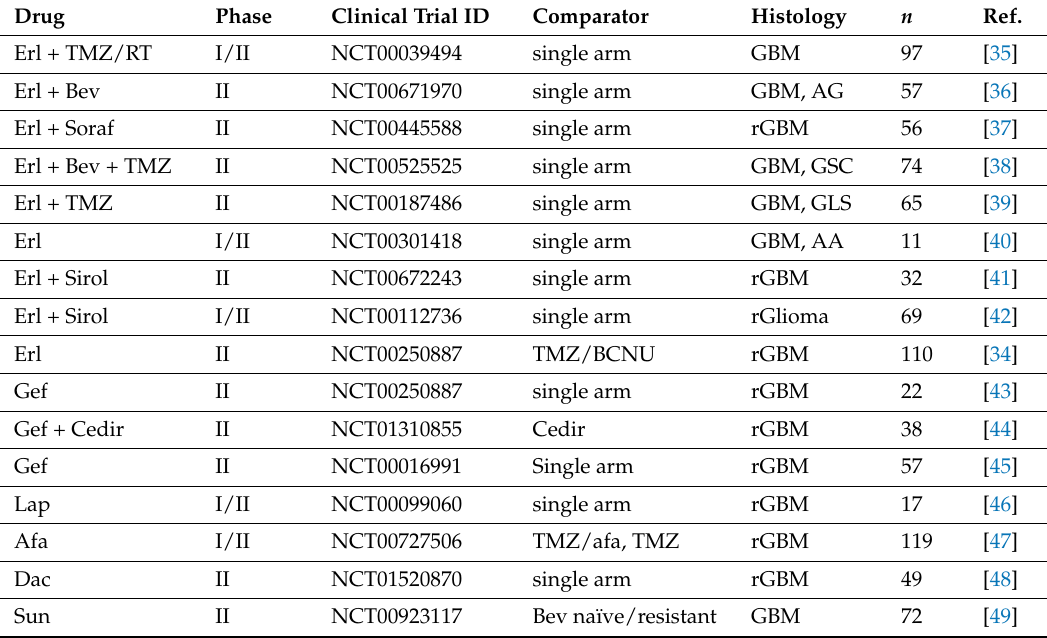
Table 1. clinical trials of EGFR-TKIs in